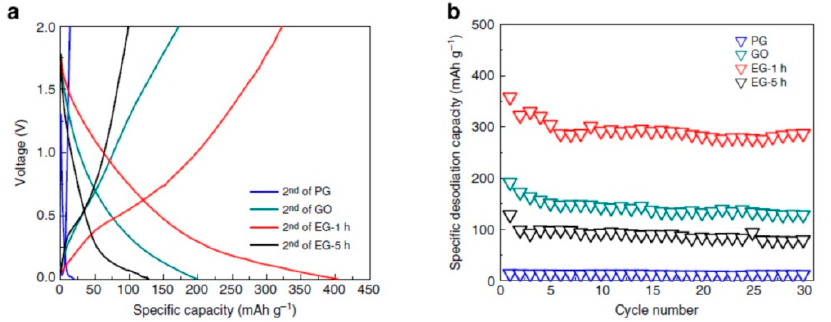
Figure 12. Electrochemical performances of graphite (PG), graphene oxide (GO), and expanded graphite (EG) anodes in sodium-ion batteries: ( a ) charge/discharge curves for the second cycles; ( b ) short-term cycling stability. Reprinted with permission from the Springer Nature Customer Service Center GmbH